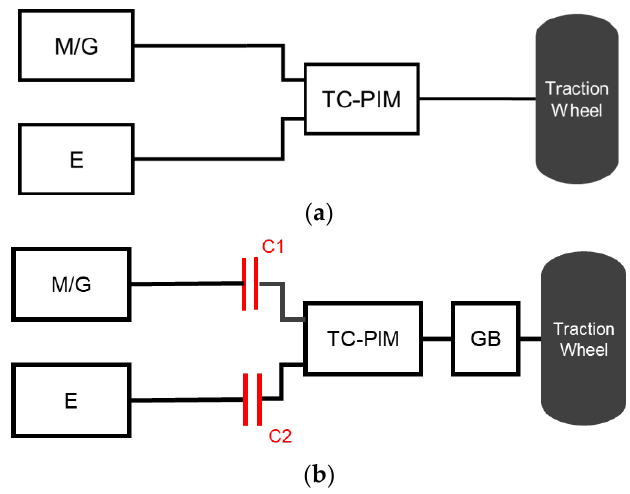
Figure 4. ( a ) Basic driveline architecture for the torque-coupled-type PIM (TC-PIM). ( b ) Clutches added driveline architecture for TC-PIM.